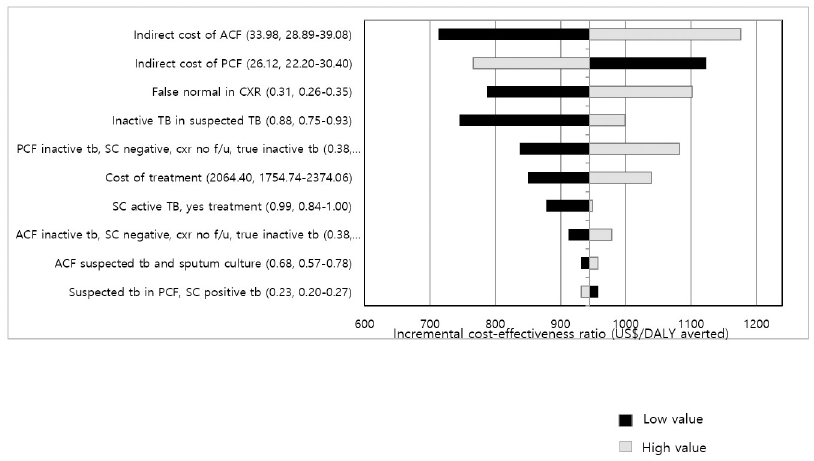
Fig 2. Impact of parameters used in this model on the cost-effectiveness of ACF with CXR and semi-PCF with CXR. The bars represent the incremental cost-effectiveness ratio at the lower (black bar) and higher (gray bar) values for each variable. TB = tuberculosis, CXR = chest X-ray, ACF = active case finding, semi-PCF = passive case finding, SC = sputum culture test.